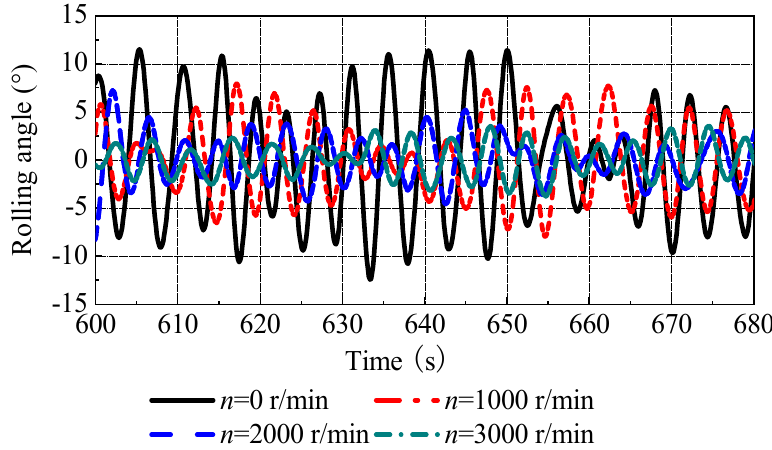
Figure 9. Time-series roll motion of ship for varying flywheel spin rates.